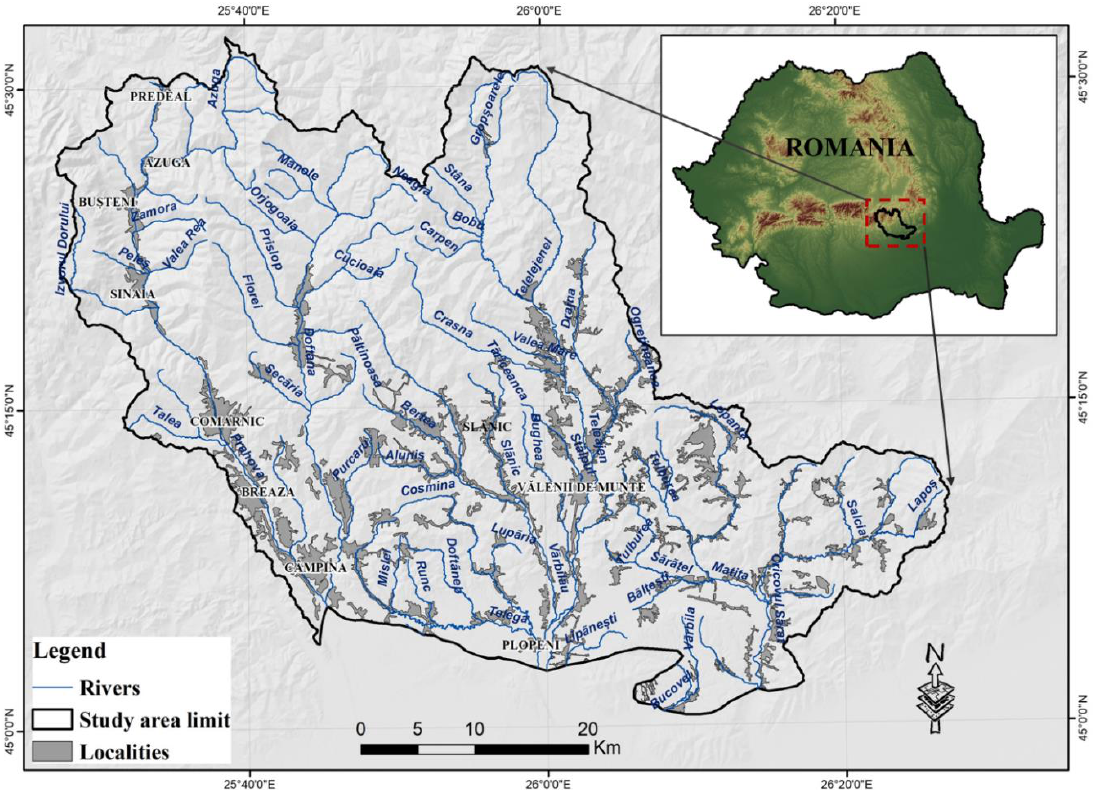
Figure 2. Study area location.